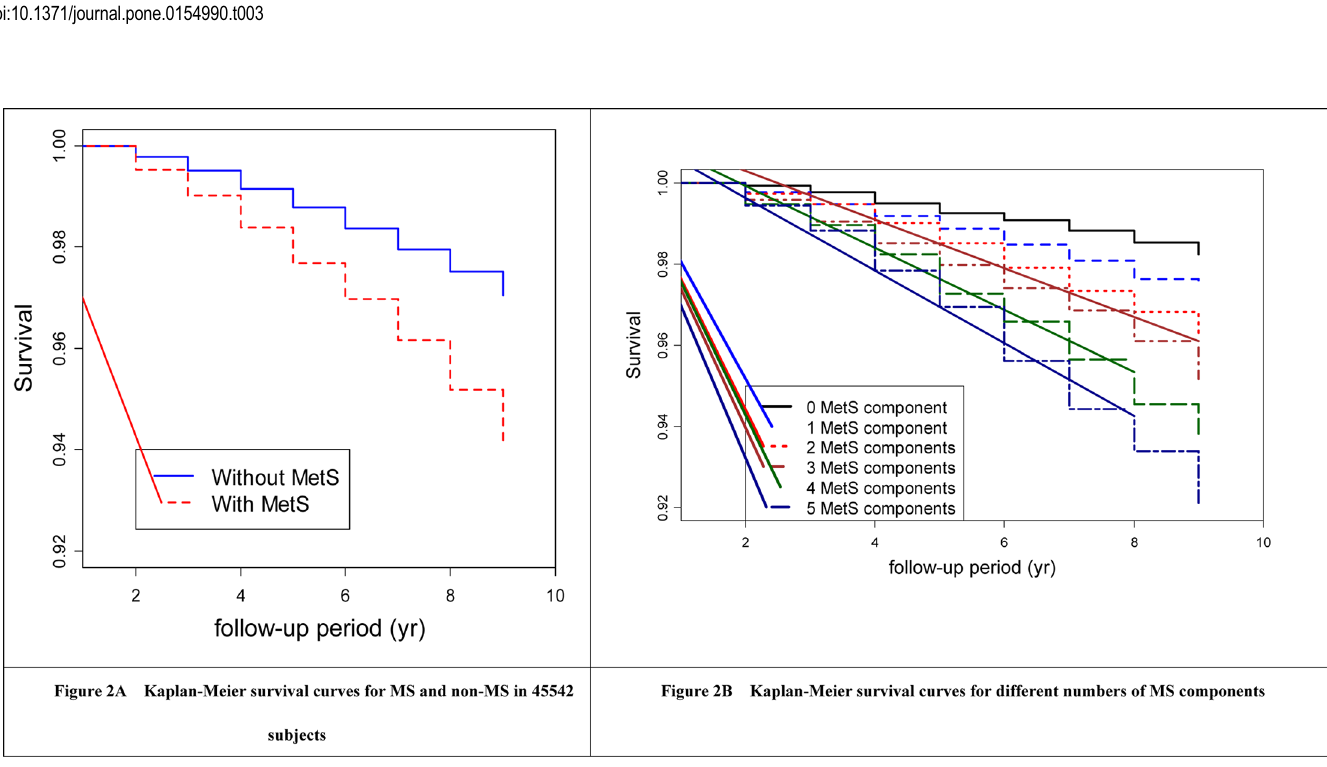
Fig 2. Kaplan-Meier survival curves for